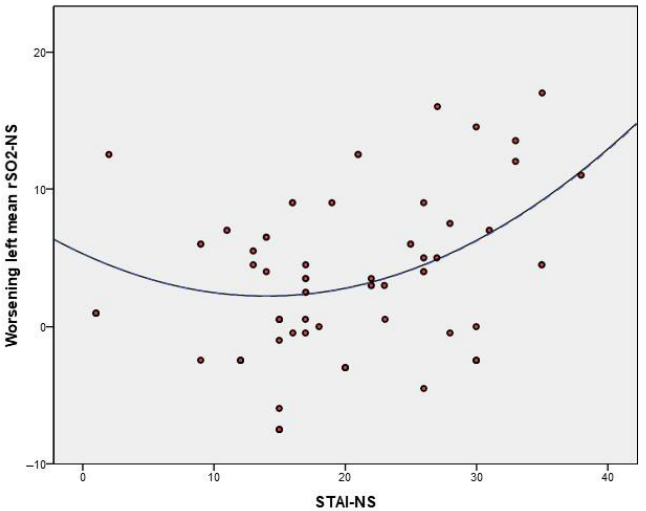
Figure 2. Relationship between the STAI score in NS condition and decrease rSO 2 in the left side.